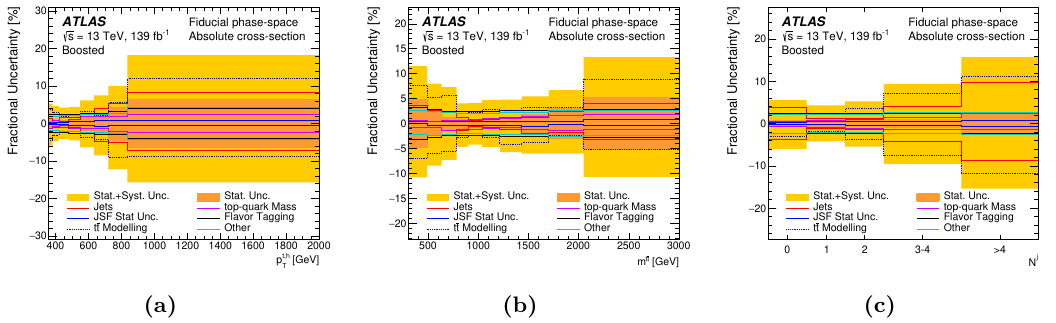
Figure 8. Fractional uncertainties of the absolute cross-section measurement as a function of (a) p ), (b) invariant mass of the t ¯ t system ( m t ¯ t ) of the hadronically decaying top quark ( p t,h T T and (c) the number of additional jets in the event ( N j ). The line labelled ‘Jets’ includes the uncertainties from the JES, JER and JVT requirements. The line labelled ‘ t ¯ t Modelling’ includes all the uncertainties discussed in section 5.4, with the exception of the uncertainty in the top-quark mass, which is shown